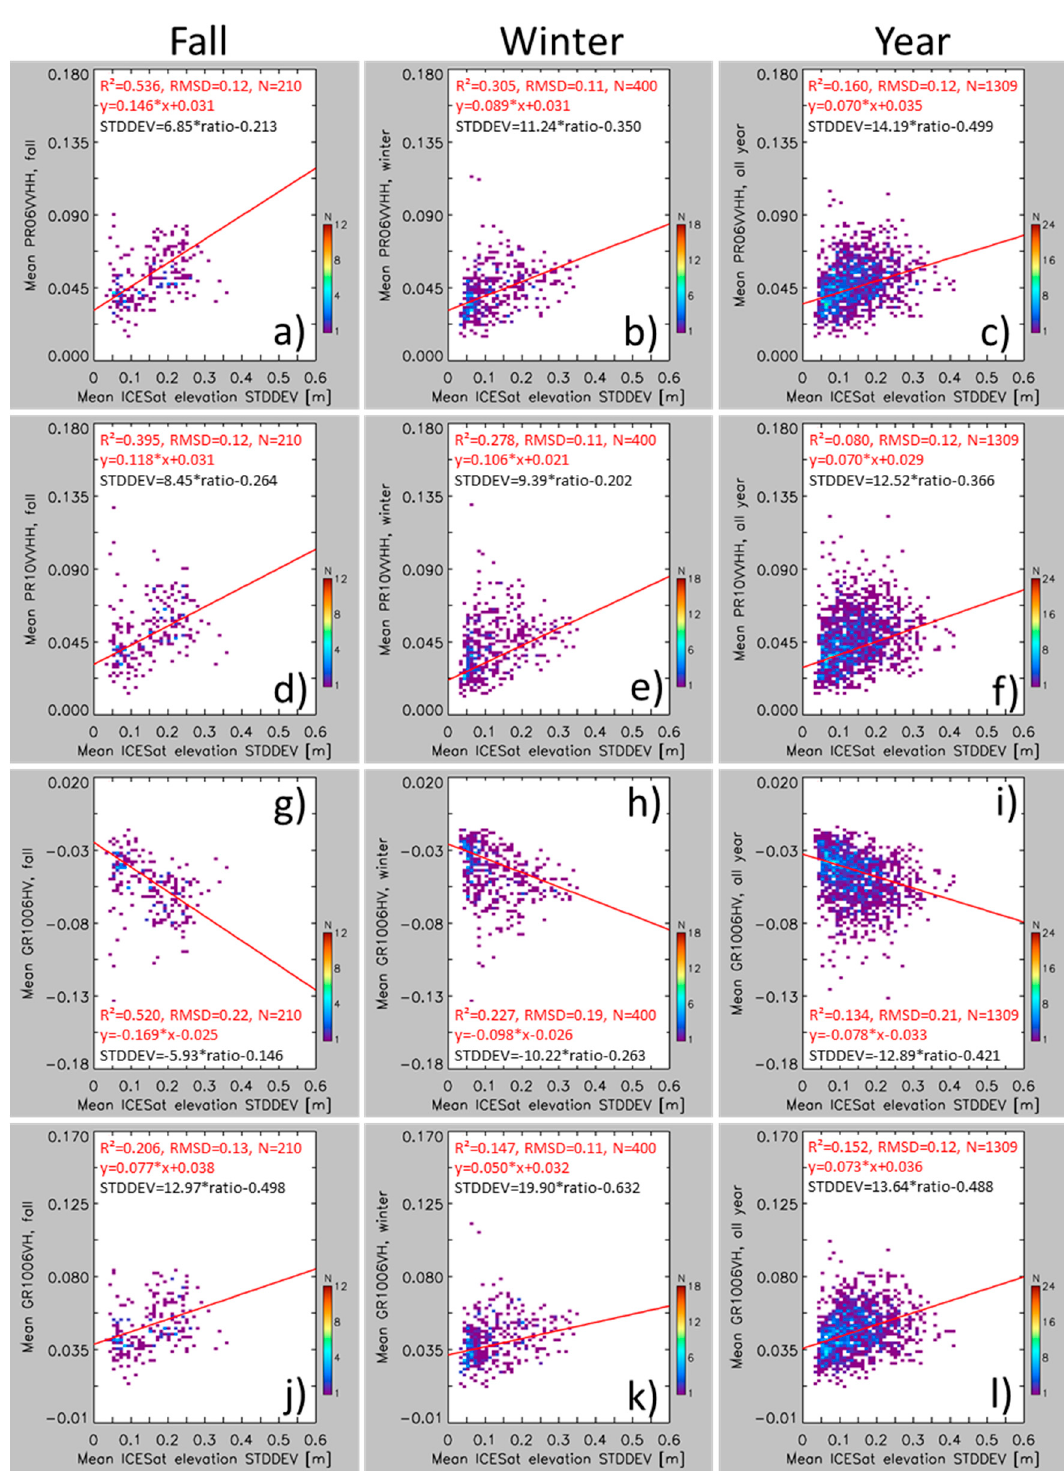
Figure 7. The two-dimensional histograms of PR or GR versus the ICESat surface elevation standard deviation using a bin size of 0.01 m for the ICESat data and a bin size for GR or PR that divides the y-axis similarly for all four ratios shown. The red line denotes the linear regression whose equation is given (in red) in each image together with the squared linear correlation coe ffi cient R 2 , the total number of data pairs, and the RMSD. The equation beginning with STDDEV (in black) is the inverse of the linear regression equation. ( a – c ) PR06; ( d – f ) PR10; ( g – i ) GR1006HV; and ( j – l ) GR1006VH (see also Table